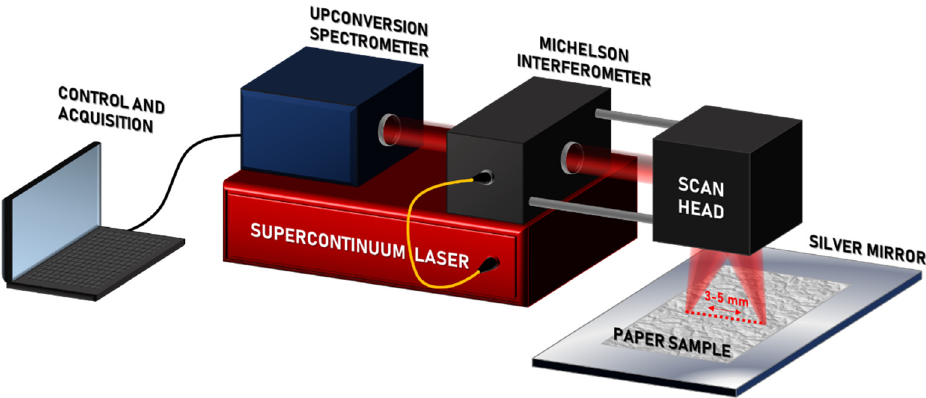
Figure 1 . Diagram of the MIR OCT measurement setup. Figure 1. Diagram of the MIR OCT measurement